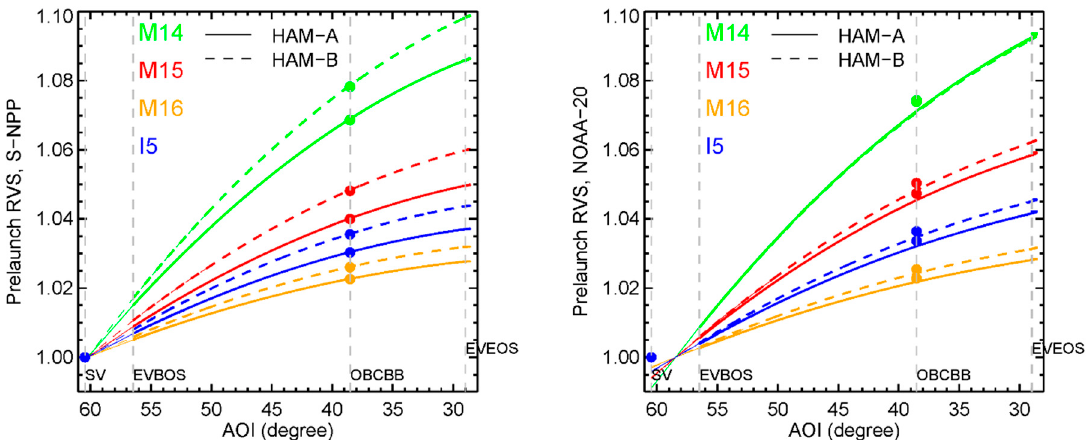
Figure 1. Diagram of Visible Infrared Imaging Radiometer Suite (VIIRS) scan pattern. Scan angles and angle of incidences (AOIs) at space view (SV), blackbody (OBCBB), the beginning of Earth View (EV) scan (EVBOS), nadir, the end of EV scan (EVEOS), and AOI min are also given.